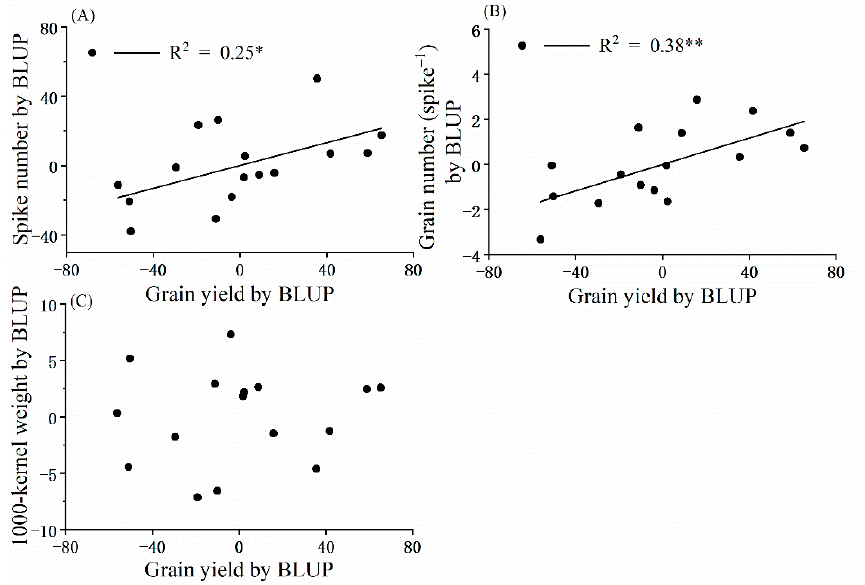
Figure 2. The relationship between grain yield by best linear unbiased prediction (BLUP) and ( A ) spike number by BLUP; ( B ) grain number by BLUP; and ( C ) 1000-kernel weight by BLUP. Only the significant linear regressions are shown. * p < 0.05; ** p < 0.01.